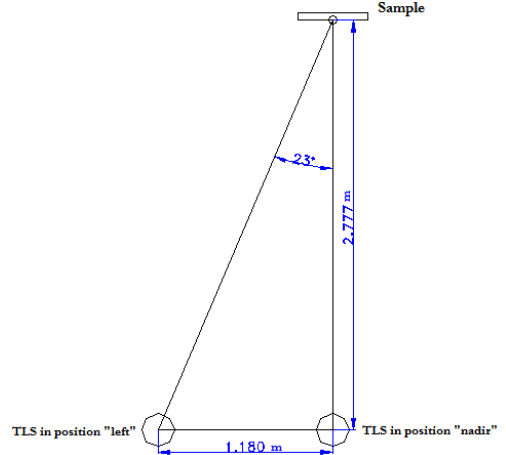
Figure 4 - Layout for the data